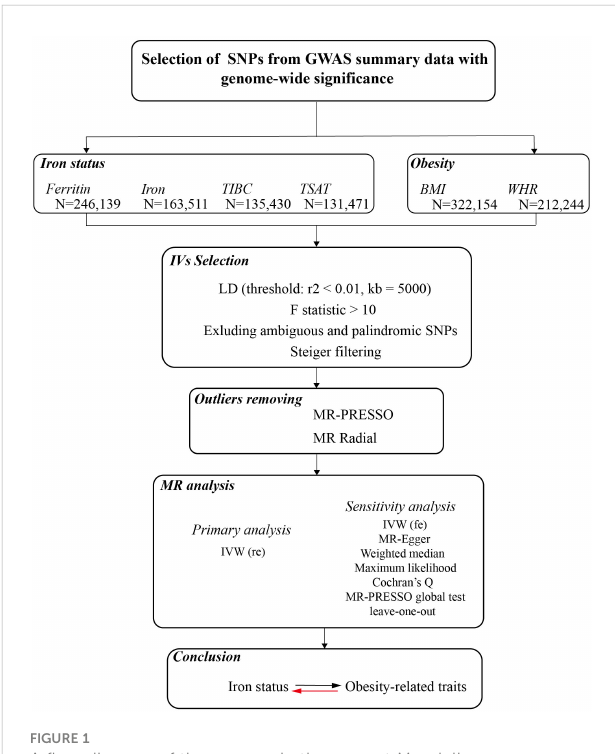
FIGURE 1 A fl ow diagram of the process in the current Mendelian randomization